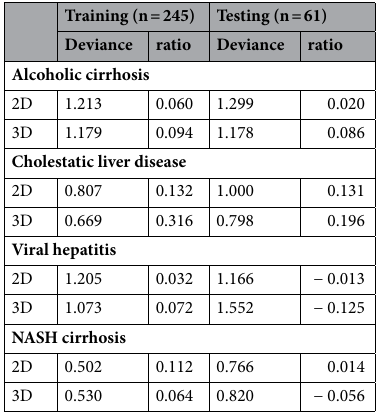
Table 5. Results of the least absolute shrinkage and selection operator (LASSO) logistic regression model for training and testing subsets. NASH, nonalcoholic steatohepatitis.